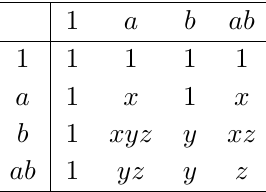
Table 1 . Representative normalized cocycles for H 2 ( Z 2 × Z 2 , Z 2 ) . For example, C ( a, b ) = 1 , C ( b, a ) = xyz